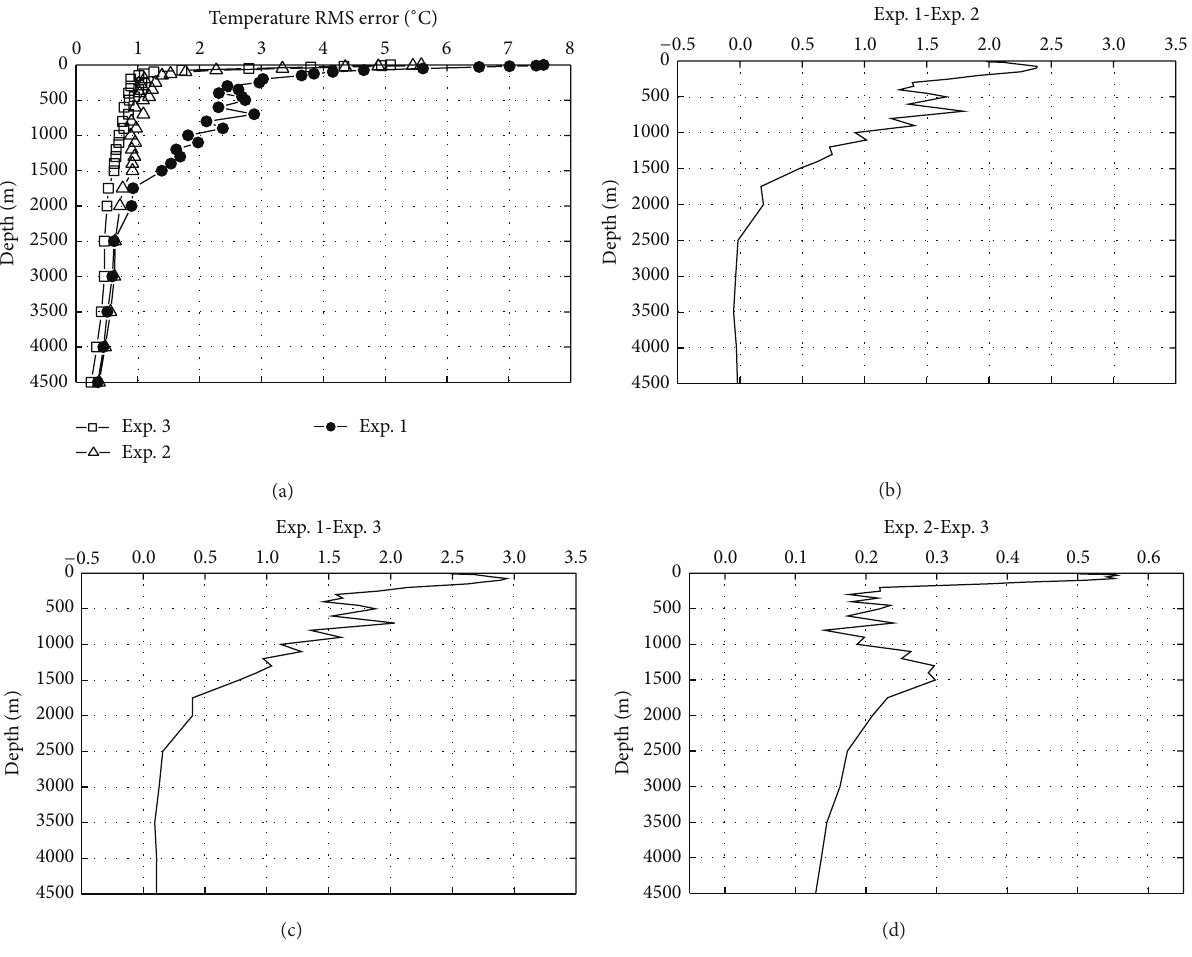
Figure 3: (a) The vertical structure of temperature RMSE of Experiments 1 (solid line with solid circle), 2 (solid line with hollow up-triangle), and 3 (solid line with hollow square) using (3); (b) the temperature RMSE of Experiment 1 minus that of Experiment 2; (c) is for Experiment 1 minus Experiment 3; (d) is for Experiment 2 minus Experiment 3. Unit: ∘